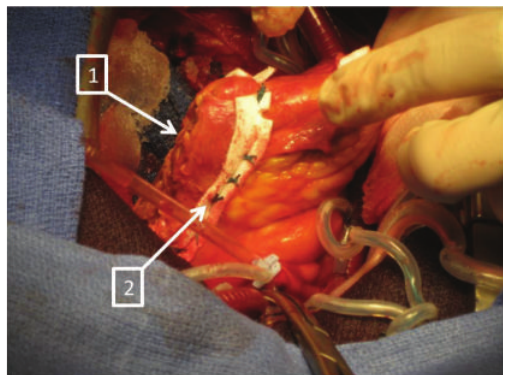
Figure 1: Arrows entitled (1) show the left-ventricle rupture stitched during cardiac surgery with the ECMO device. Arrows entitled (2) depicts two strips of felt placed lengthwise on the epicardial surface and used to support the closure of the rupture from outside the myocardium, using horizontal mattress sutures of 2/0 polyester.